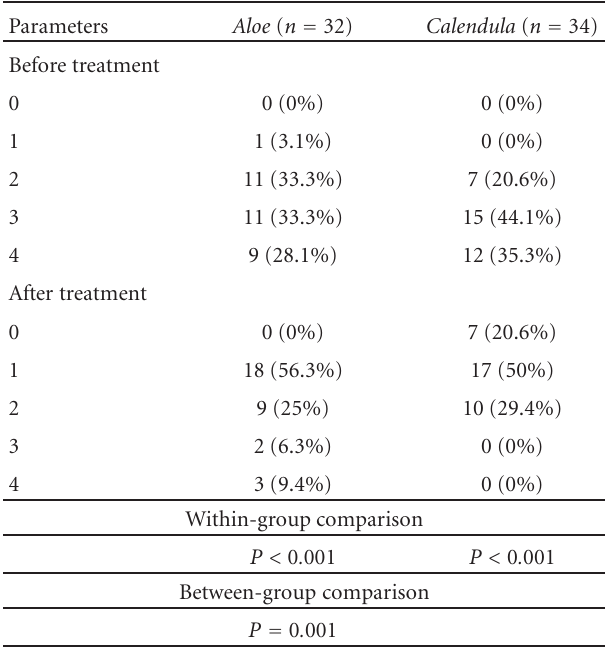
Table 3: Severity of diaper dermatitis in the study groups before and after